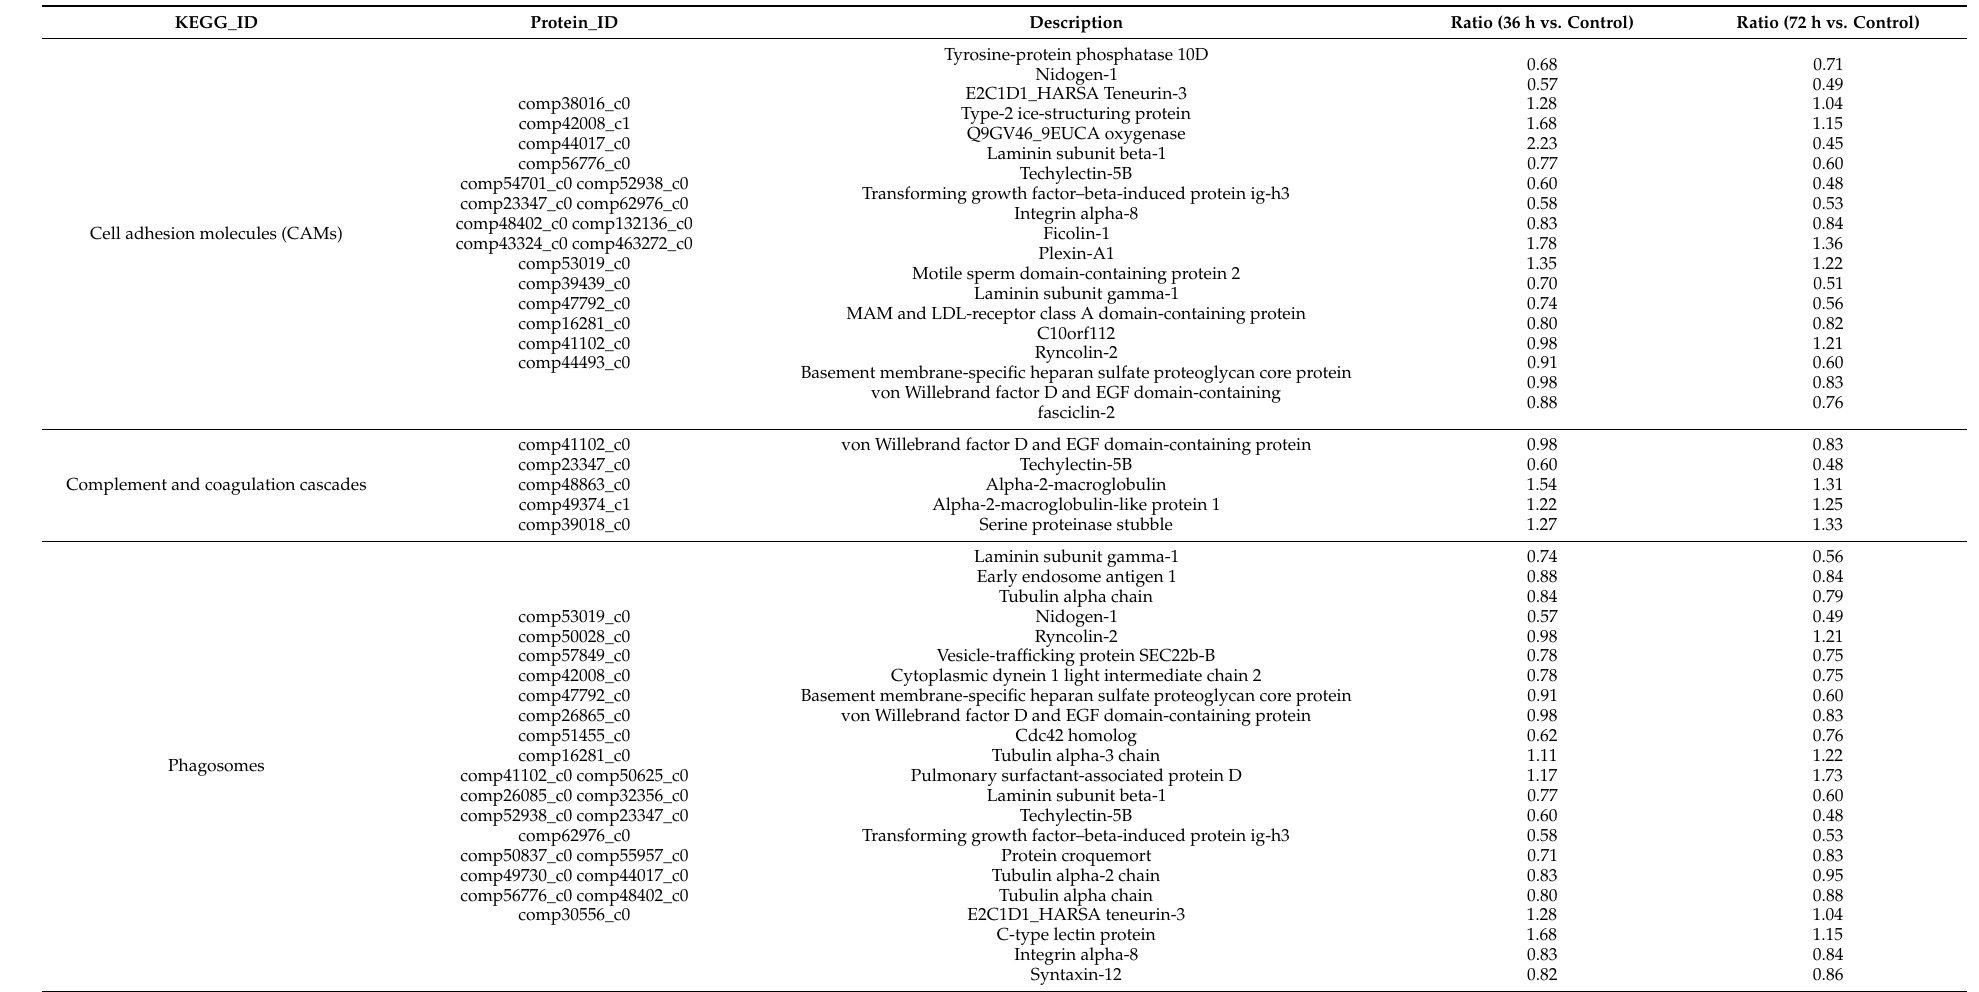
Table 2. KEGG immune-related pathways and their associated differentially expressed proteins identified in hemocytes by iTRAQ. Fold-changes were calculated in comparison with the control